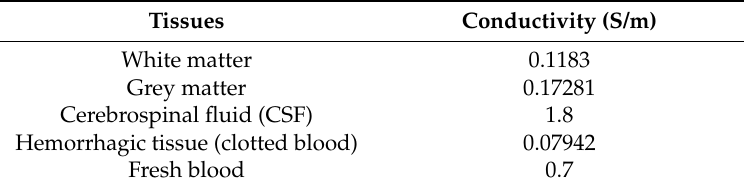
Table 1. The conductivity of different brain tissues at 50 kHz